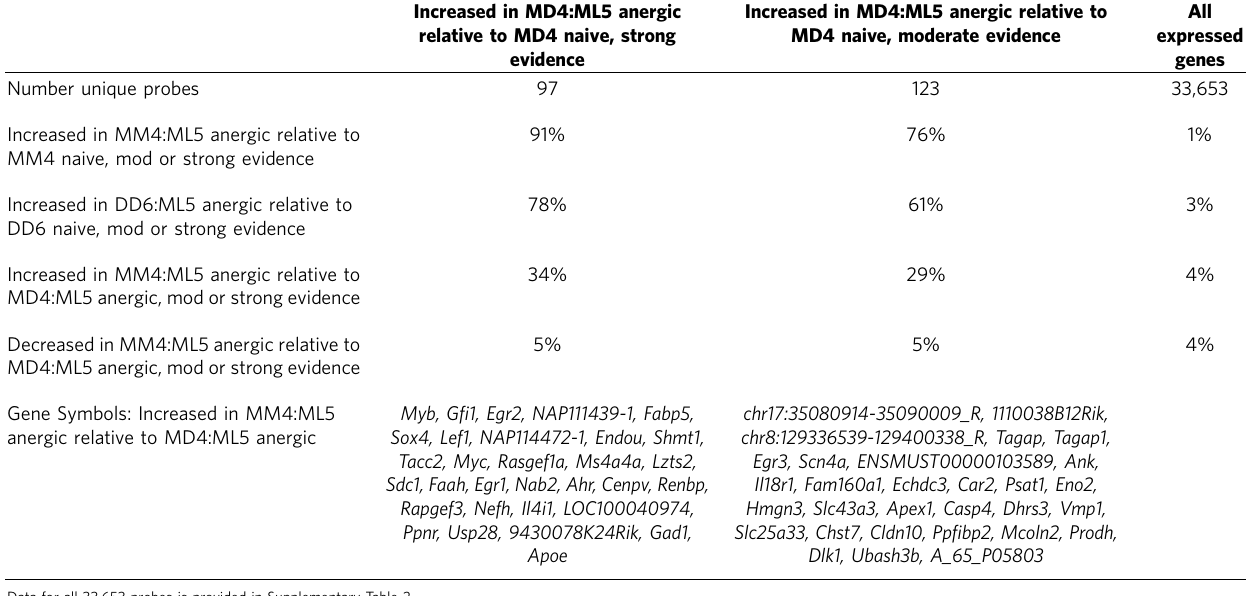
Table 1 | Summary of microarray data analysed by